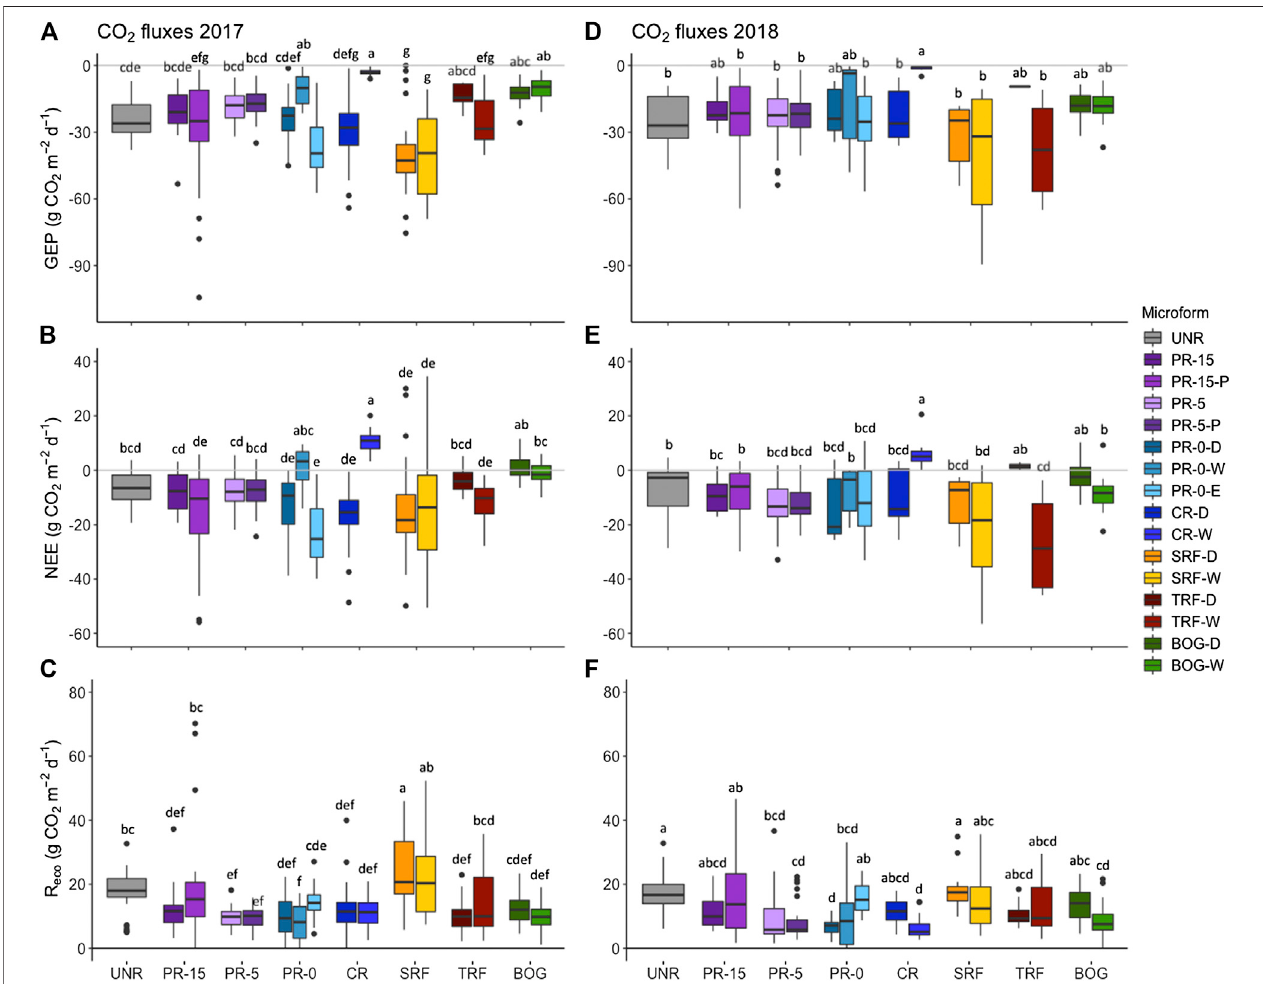
FIGURE 6 | Measurements in all monitoring sectors* during the monitoring season of 2017 (A – C) and the season of 2018 (D – F) show the mean gross ecosystem production (GEP in g CO 2 m − 2 d − 1 ) at a photosynthetically active radiation (PAR) photon fl ux density ≥ 1,000 μ mol m − 2 s − 1 (A+D), the mean net ecosystem exchange (NEE in g CO 2 m − 2 d − 1 , B+ E), and the mean ecosystem respiration (R eco in g CO 2 m − 2 d − 1 , C+ F). Groups with the same letters are not signi fi cantlydifferent. Statistical results of the ANOVAs for 2017 show GEP: